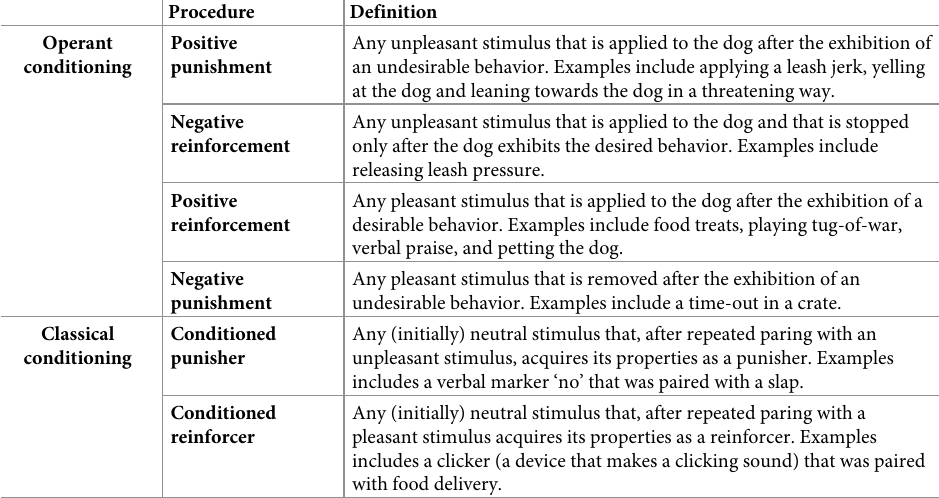
Table 1. Definition of the conditioning procedures used for training